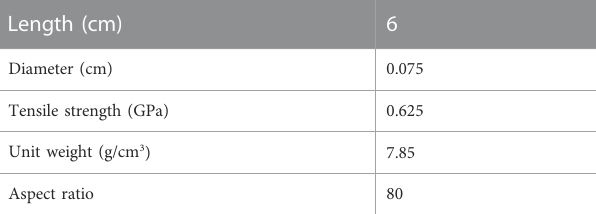
TABLE 4 Steel fi bre ’ s physical characteristics.